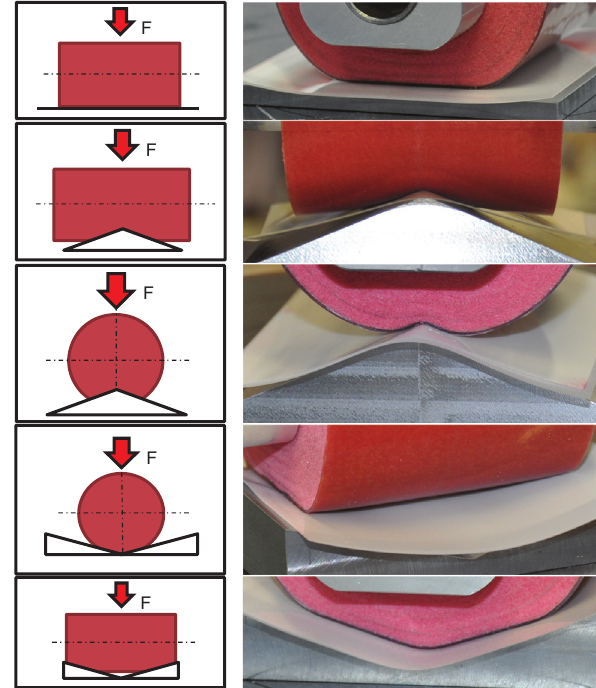
Figure 16 Analytical results for required roller indentation for roller approaching at any angle for both constant angle and geodesic path planning.